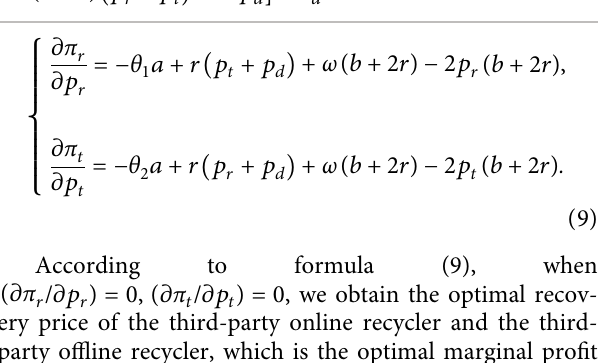
ery price of the third-party online recycler and the